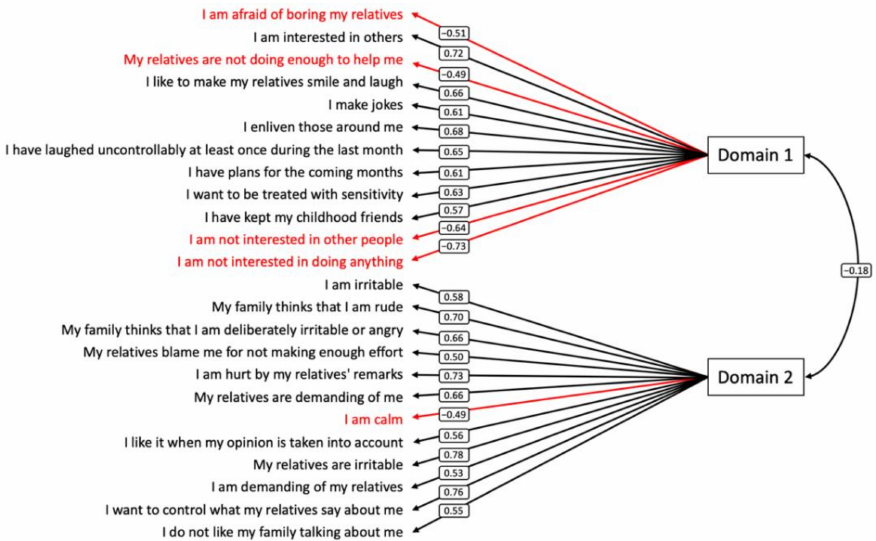
Figure 1. Path diagram of the final exploratory factor analysis. Black and red one-headed arrows represent positive and negative standardized loadings, respectively. The two-headed arrow represents correlation. Domain 1 reflects social motivation and Domain 2 reflects emotional